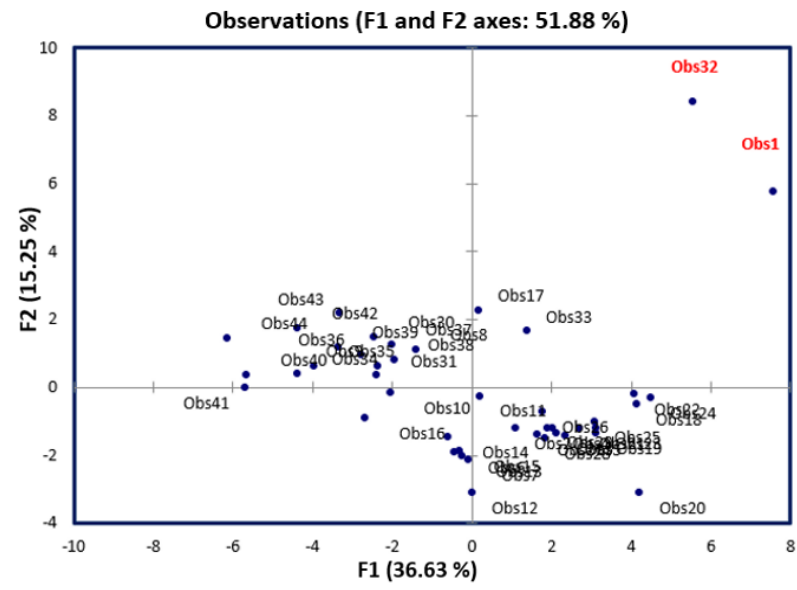
Figure 1. Data visualization on the first two principal components.